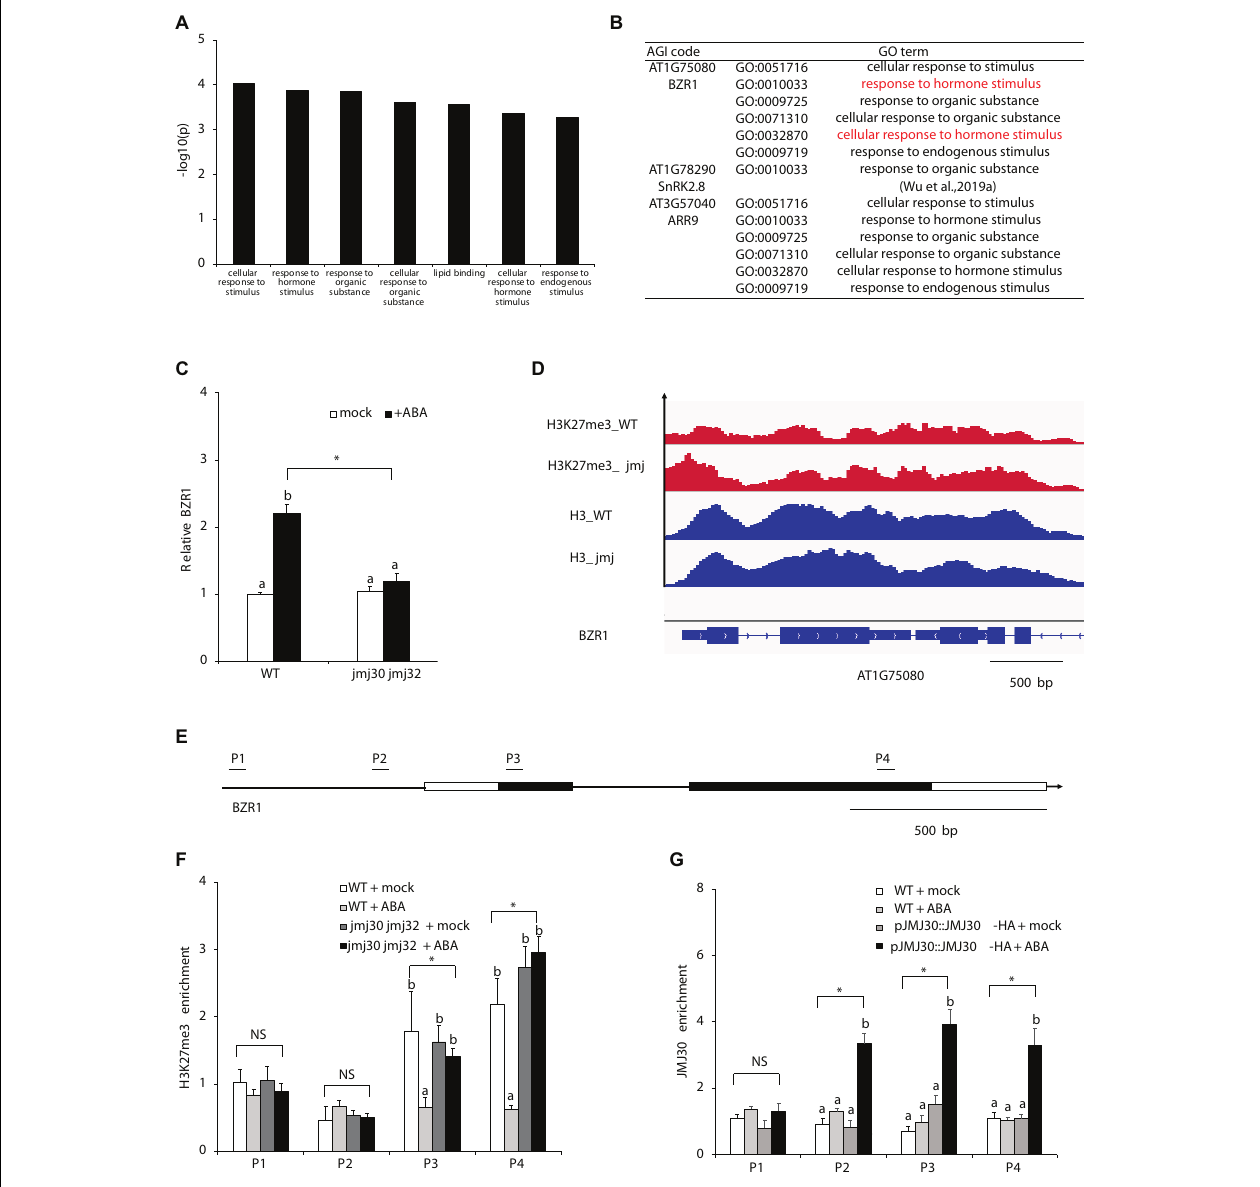
FIGURE 3 | JMJ30 protein removes H3K27me3 from the BZR1 loci in response to ABA. (A) AgriGO analysis revealed seven ABA- and JMJ-dependent biological processes. (B) The GO terms of some plant hormone response genes, such as BZR1 , were included. (C) BZR1 expression levels in wild type and jmj30-2 jmj32-1 after ABA treatment, based on RT-qPCR. Asterisks indicate significant differences based on one-way ANOVA test. p < 0.05. Different letters indicate significant differences, whereas same letters indicate non-significant differences based on post hoc Tukey’s HSD test. p < 0.05. (D) H3K27me3 levels at the BZR1 loci in mock-treated wild type and jmj30-2 jmj32-1 . (E) PCR fragments (P) and schematic diagram of genes are shown below the ChIP data. White bars, untranslated regions; black bars, protein coding regions. (F) H3K27me3 ChIP at the BZR1 loci in wild type and jmj30-2 jmj32-1 with and without ABA. (G) JMJ30-HA ChIP at